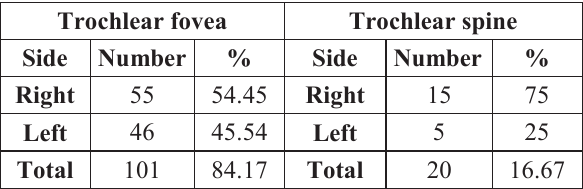
Table-1: Incidence of trochlear fovea and spine